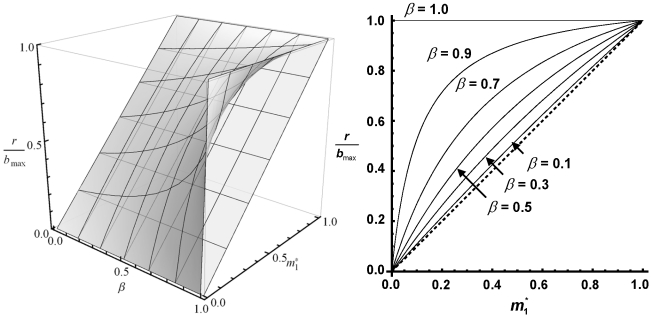
Invasion capability of an inferior competitor having no-sex investment.Invasion capability of an inferior competitor when it is not investing in sex (m0 = 0). Left panel. Parametric space defined by r/bmax, the density-dependent sexual investment at equilibrium of the resident species (m1*) and relative competitive ability of the invader (β). The linear surface is defined by the maximum possible sexual investment at equilibrium (mi
* = r/bmax), so that the values below that surface do not allow permanence of the resident species. The non-linear surface defines an edge for a positive growth rate of an invader being competitively inferior or equivalent to the resident, so that all the values below that surface imply successful invasion. Hence, all the values between both surfaces allow stable coexistence. Right panel. Slides for different values of β of the parametric space shown on the left panel. Dotted line shows the maximum possible investment in sex. Values between solid lines and the dotted line are the parametric values allowing stable coexistence.